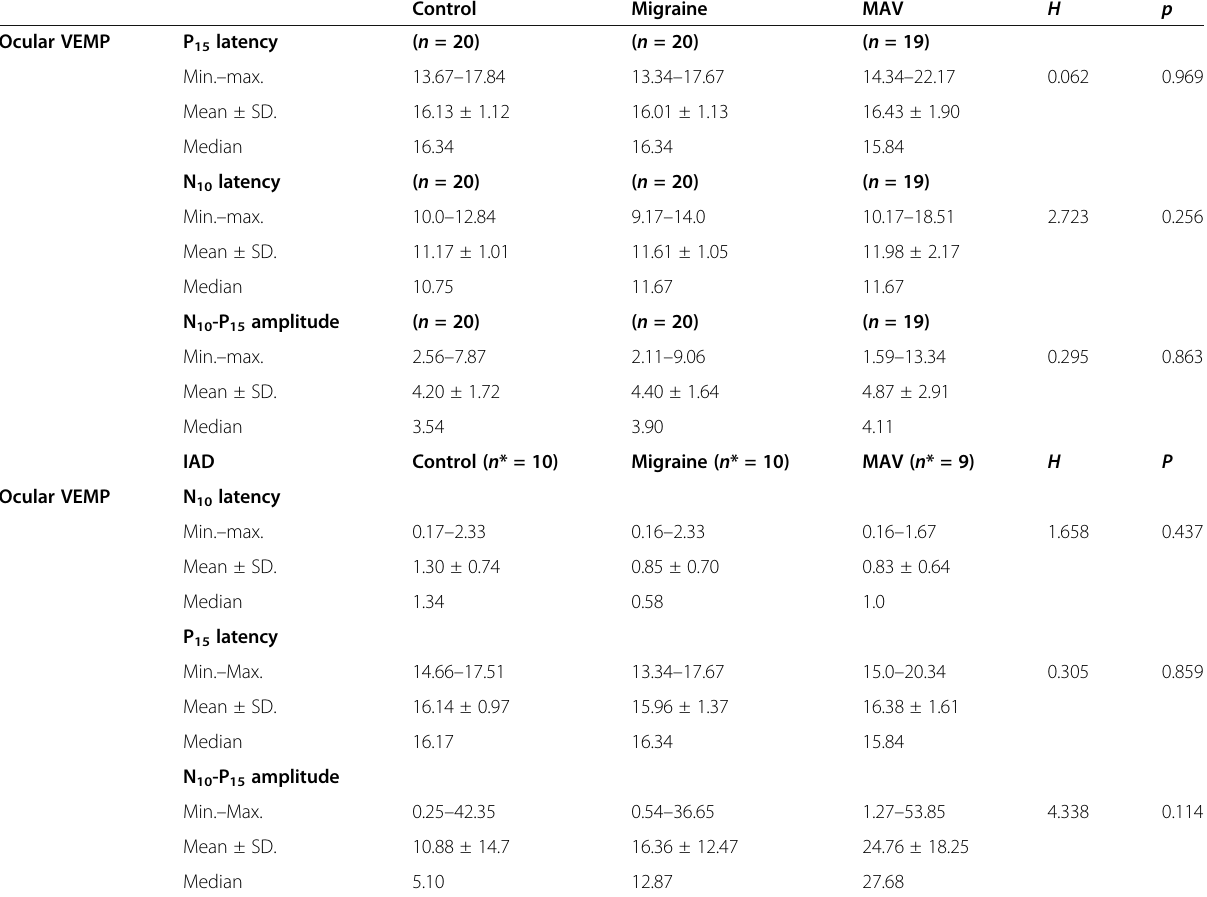
Table 2 Ocular VEMP N 10 , P 15 latencies (in ms), N 10 -P 15 amplitude (in μ V), and IAD in the three studied groups